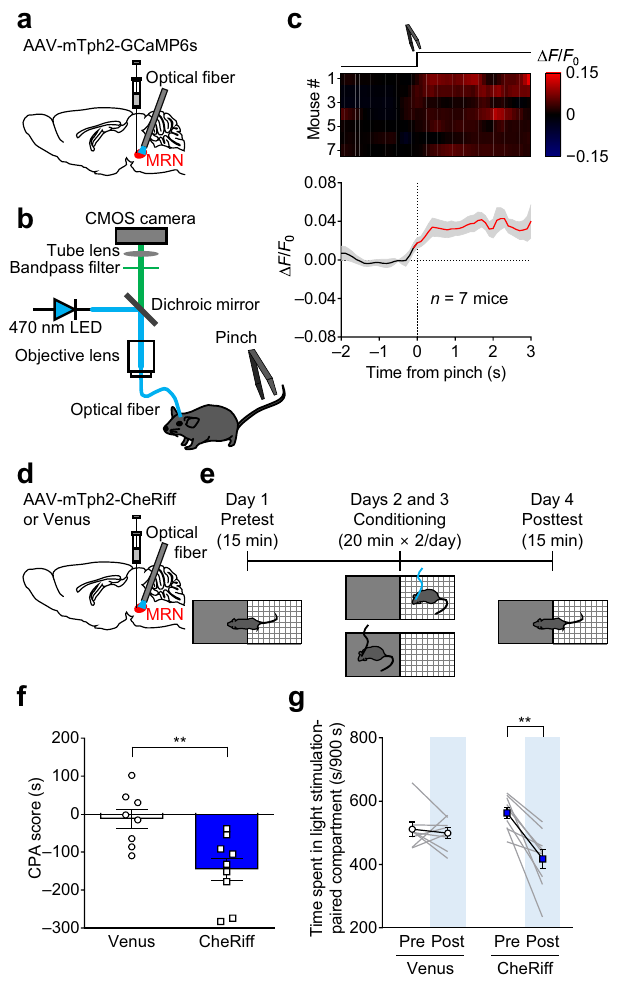
Fig. 2 | Aversive stimuli activate MRN serotonergic neurons, and their activa- tionelicitsconditionedplaceaversion(CPA).a SchematicrepresentationofAAV injectionand fi berimplantation. b Schematicofthe fi berphotometrysetupandtail pinch task in free-moving mice. c Top: heatmap of GCaMP signals (red – blue, high – low) for each trial (one trial per mouse). Each row represents the data of one mouse. n =7 mice. Bottom: averaged traces of GCaMP signals. Lines and shaded areas indicate mean and s.e.m., respectively. The red segment indicates a statisti- cally signi fi cant increase from the baseline ( P <0.05; permutation test). d SchematicrepresentationofAAVinjectionand fi berimplantation. e Schematicof the CPA test. On day 1, mice underwent the two-compartment test without light stimulation(pretest:15min).Onday2and3,miceunderwentconditioningsessions (20min×two times per day) for two consecutive days. On day 4, mice again underwent the two-compartment test without light stimulation (posttest: 15min). f Stimulation of MRN serotonergic neurons promoted CPA. The CPA scores cal- culatedasspenttimeinalightstimulation-associatedcompartmentintheposttest subtractedbythatinthepretestintheVenusandCheRiffmice(two-tailedunpaired t -test (Venus vs CheRiff), t 15 =3.401, ** P =0.0040, n =8 (Venus) and 9 (CheRiff) mice). g Spent time in the compartment associated with light stimulation was signi fi cantly decreased after conditioning sessions in the CheRiff mice but not in the Venus control mice (CheRiff: two-tailed paired t -test (CheRiff Pre vs CheRiff Post), t 8 =4.998, ** P =0.0011, n =9 mice; Venus: two-tailed paired t -test (Venus Pre vs Venus Post), t 7 =0.4957, P =0.6353, n =8 mice). Data are presented as mean± s.e.m. Error bars indicate s.e.m. Source data are provided as a Source Data fi